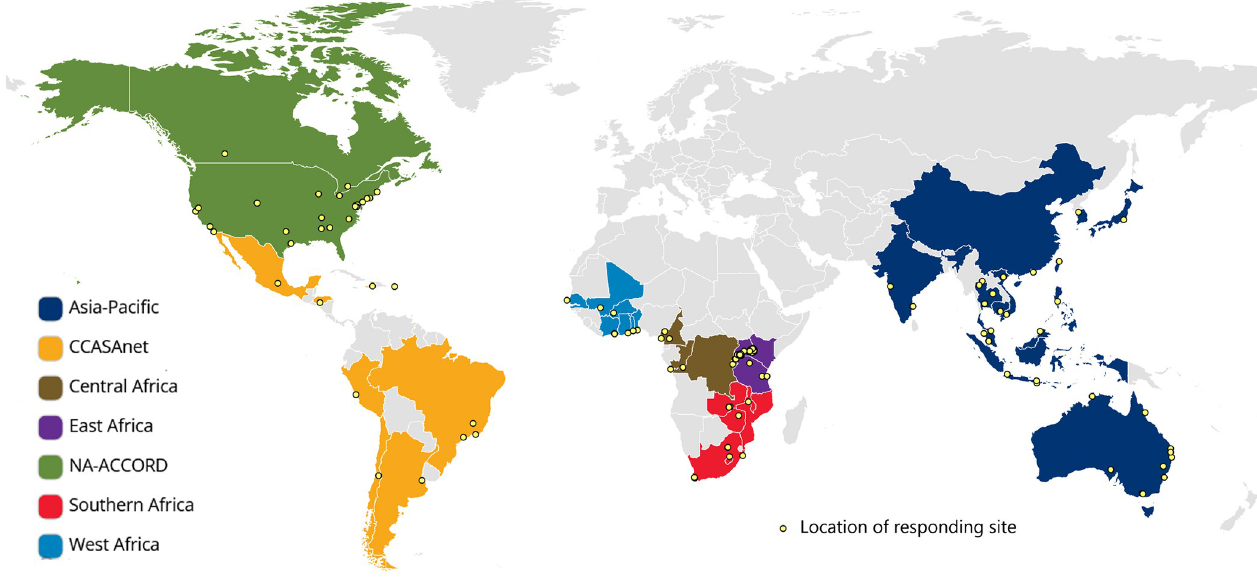
Fig 3. IeDEA regions and locations of responding sites.